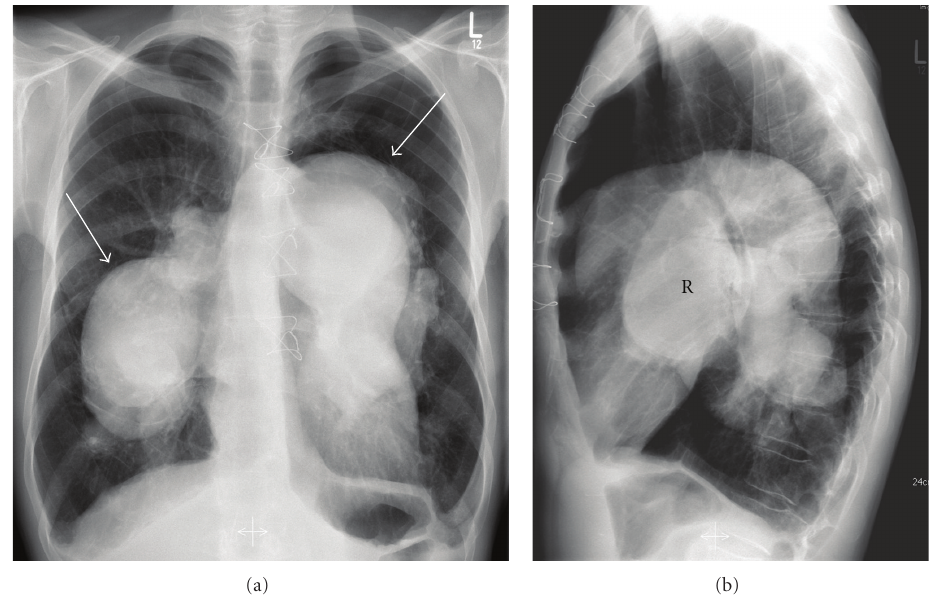
Figure 2: Chest radiographs ((a) and (b)) from 2012 showed severe dilatation of both pulmonary arteries (arrows). (R = right pulmonary